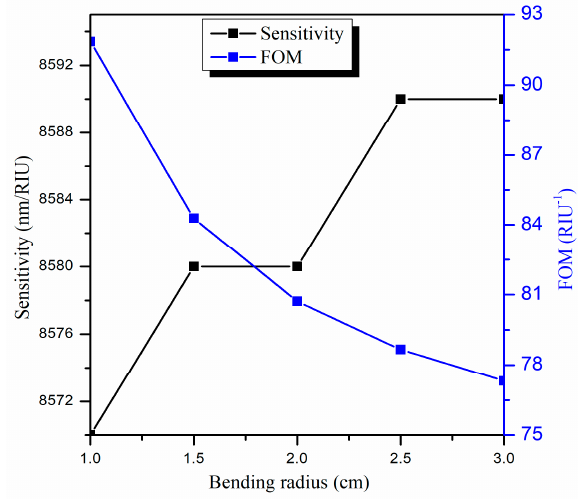
Figure 10. Variation in the sensitivity and figure of merit with various bending radii (R) for the designed U-shaped LMR sensing